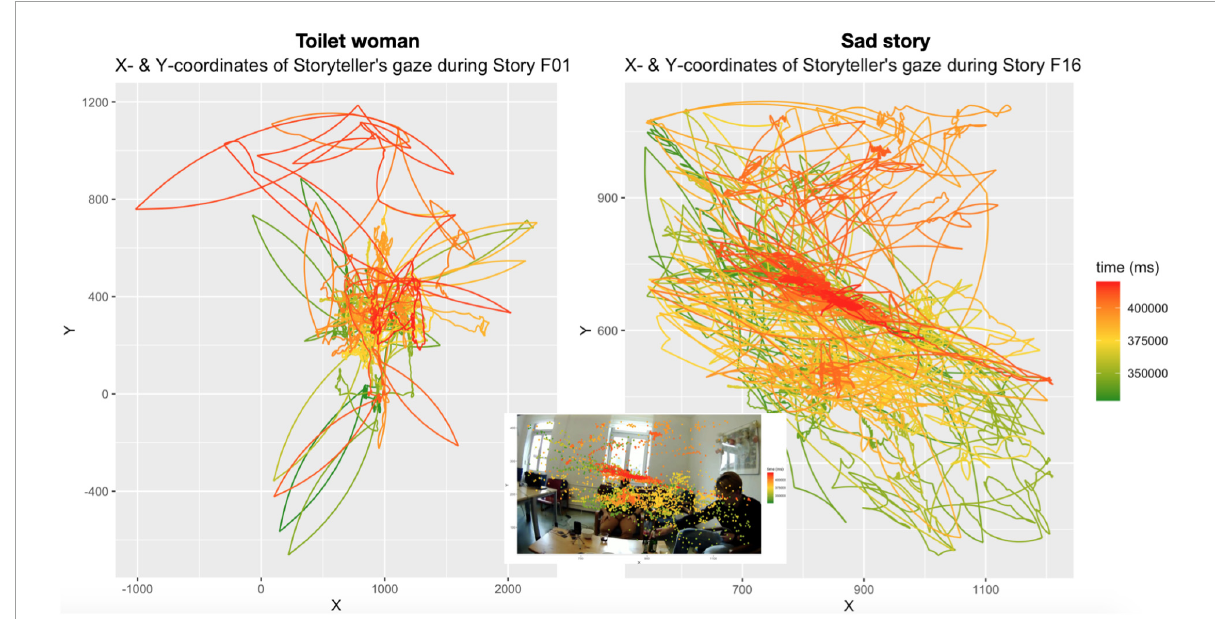
FIGURE5 Gaze movements by storytellers based on continuous color scale aligned to time: from green (story-early) to gold (mid-story) to red (story-final); Inset: gaze scatterplot overlaying still from storyteller C’s eye tracking video.